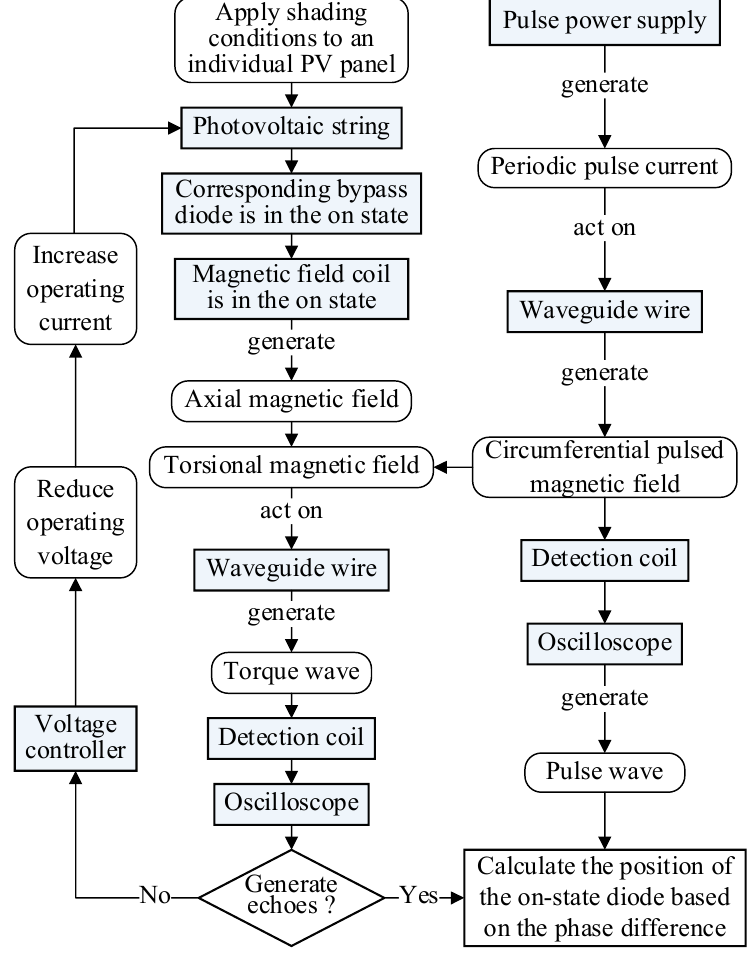
Figure 10. The process of the whole detection method. Two PV modules are connected in series to form a PV string, and shading conditions are applied to single PV modules so that its corresponding bypass diode conducts and generates a local axial magnetic field from the magnetic field coil. This magnetic field is superimposed on the pulsed circumferential magnetic field generated when the waveguide wire is passed with a periodic pulsed current to form a torsional magnetic field. Under the action of the torsional magnetic field, the waveguide wire produces a torque wave that propagates to both ends from the corresponding position. The magnetic field change caused by the end-position waveguide wire under the action of the pulse current and torque wave is detected by the detection coil, and the output waveform of the induced electromotive force generated by the detection coil is collected using an oscilloscope. Based on the phase difference between the pulse wave and the corresponding echo, the specific position of the PV module corresponding to the magnetic field coil in the on-state current can be